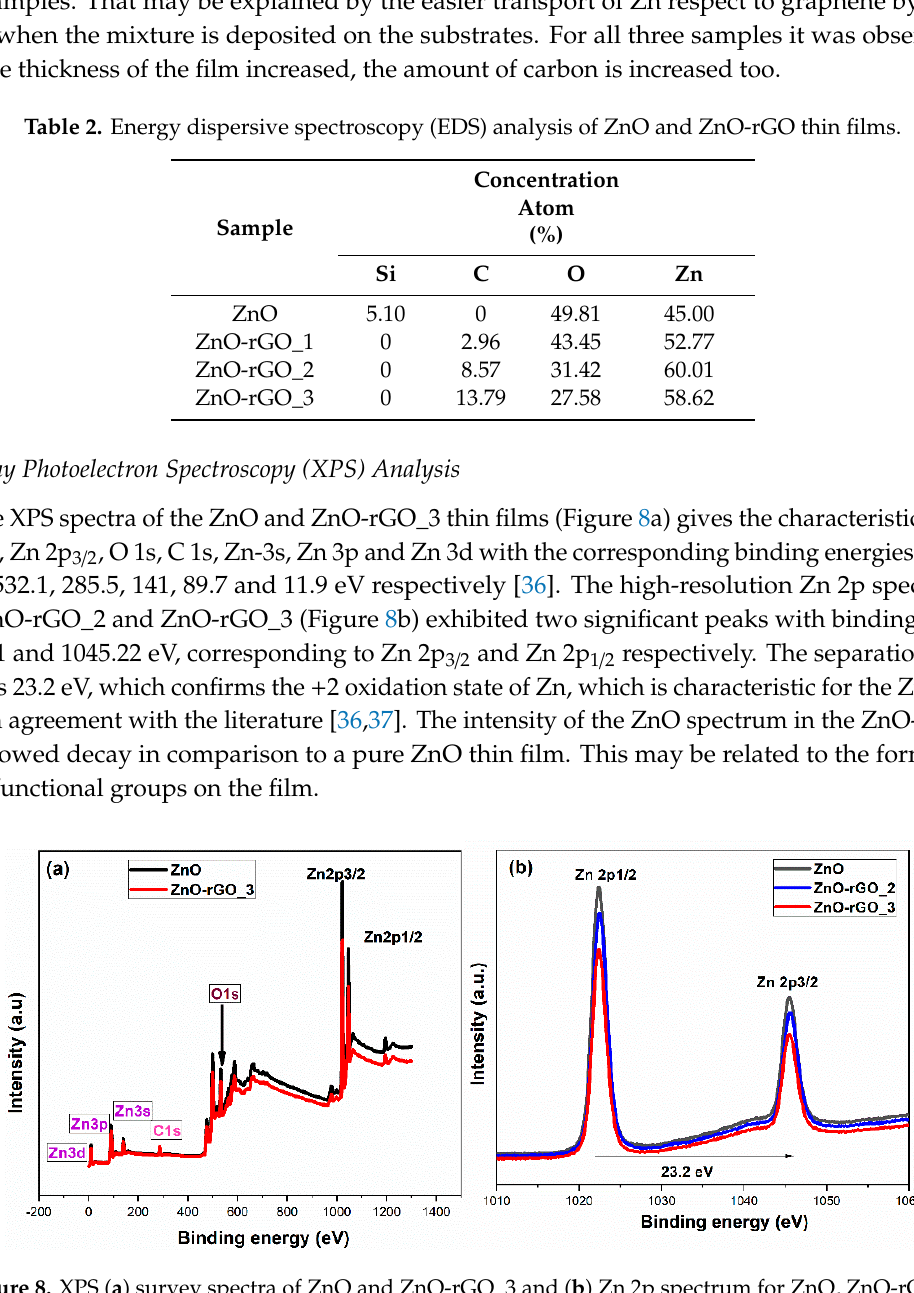
Figure 8. XPS ( a ) survey spectra of ZnO and ZnO-rGO_3 and ( b ) Zn 2p spectrum for ZnO, ZnO-rGO_2 and ZnO-rGO_3.